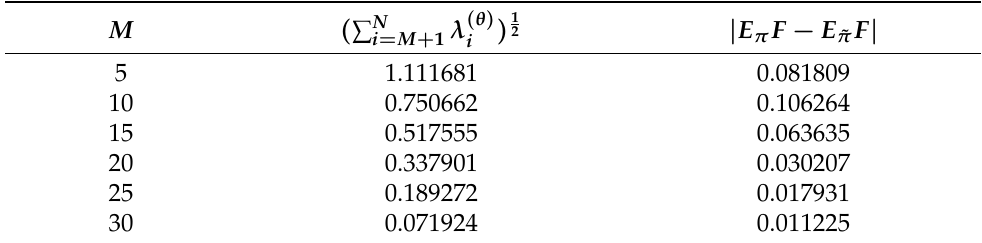
E π F E ˜ π F when the K-L expansion is truncated to M terms. Here l 1 = 0.1, | − | = f